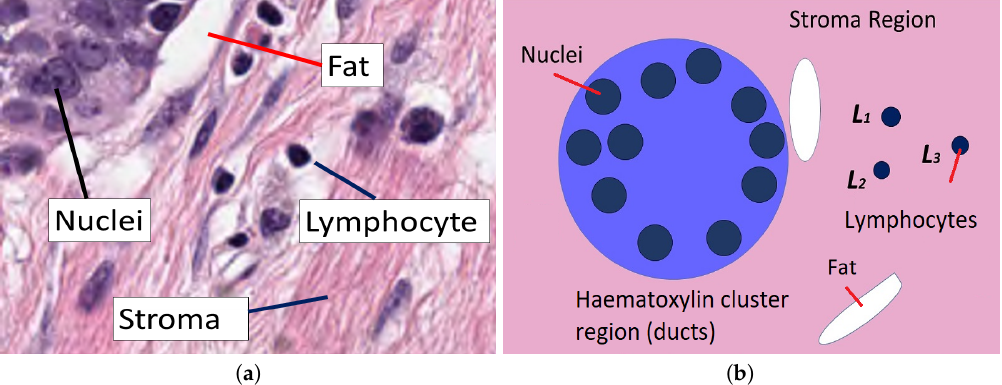
Figure 1. ( a ) Stroma region which shows several clusters, regions of fat as well as some lymphocytes. ( b ) Graphical description of the elements that are analysed in this work. Within a stroma, the connective tissue shown in pink region, ducts appear as clusters stained with haematoxylin and contain several nuclei. Outside these ducts, regions of fat appear white and lymphocytes appear